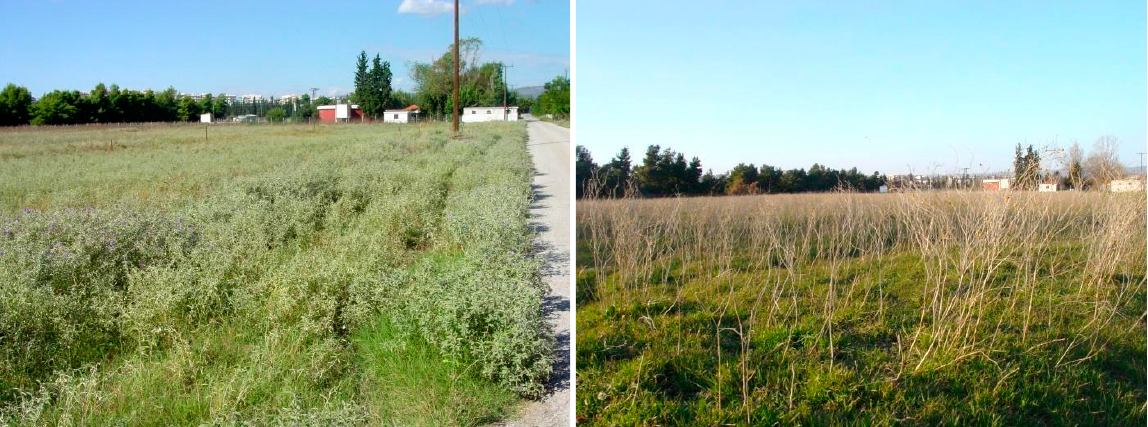
Figure 6. Geomorphology of the Greek territory with the basic road network connecting the capitals of local prefectures and overview of the inventories performed for Solanum elaeagnifolium (black lines). The zoomed-in area indicates an ex- ample of individual inventories performed from one city (Thessaloniki, Northern Greece) to other destinations such as exit roads to: Athens (1), Igoumenitsa (2), Edessa (3), Evzoni (4), Kilkis (5), Serres (6), Alexandroupoli (7), Kavala (8), northern Chalkidiki (9) and southern Chalkidiki (10).